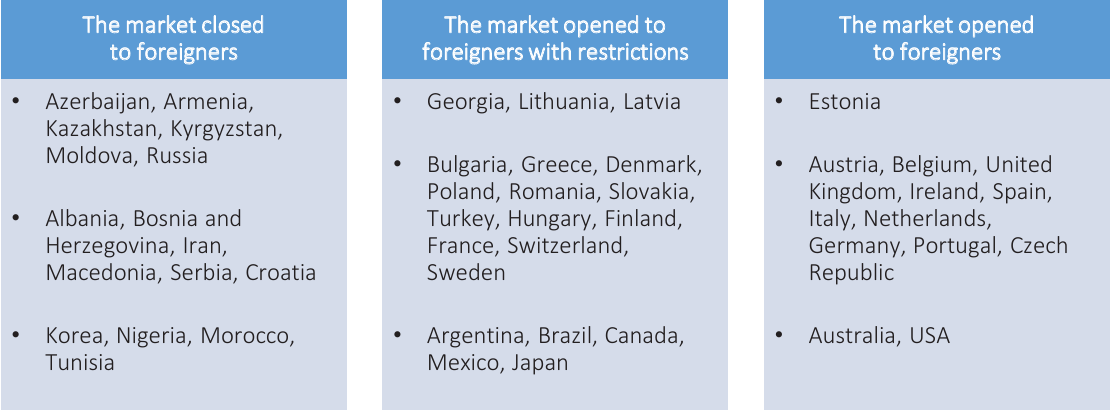
Figure 3. Land market types classifications according to restrictions for